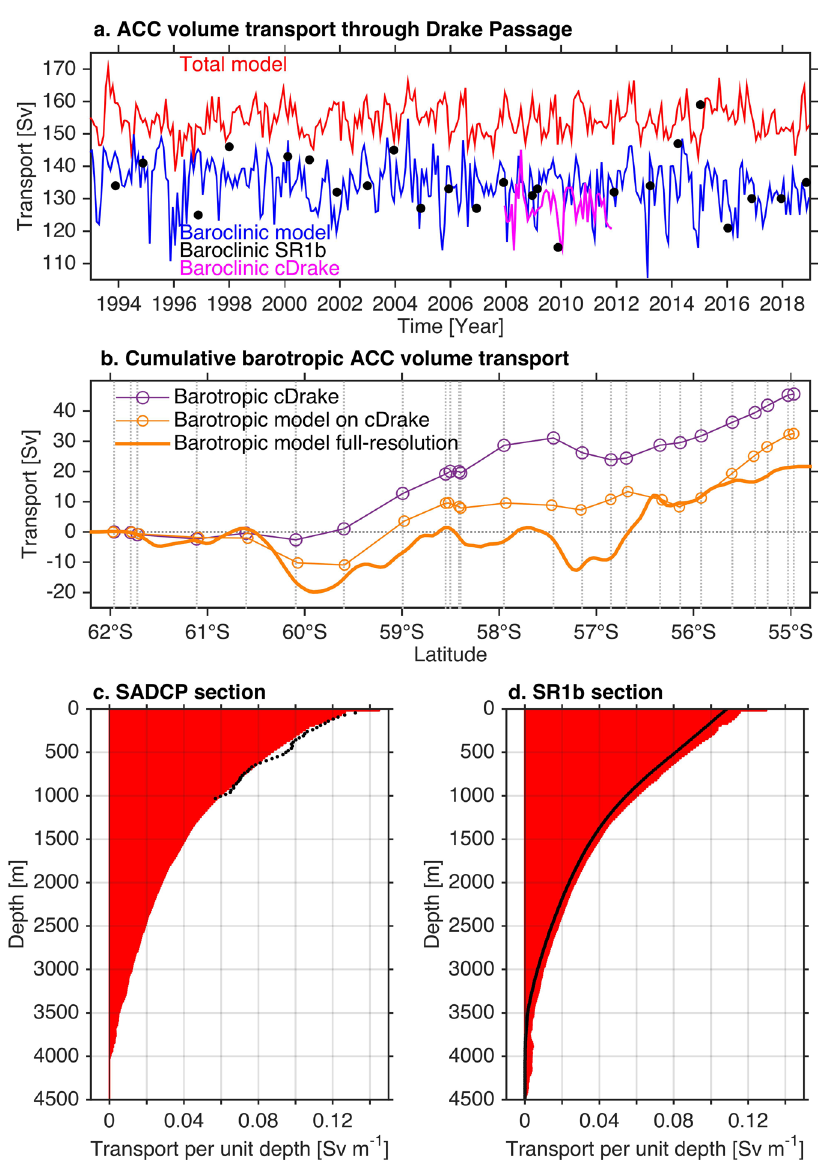
Fig. 5 Volume transport through Drake Passage. a Monthly values of total (red curve) and baroclinic (blue curve) transports across the repeat SR1b hydrographic section in Drake Passage computed from the HYbrid Coordinate Ocean Model (HYCOM) in comparison with baroclinic transport estimated from 24 SR1b hydrographic surveys 102 (black circles) over 1993 – 2018 and with monthly baroclinic transport (magenta curve) estimated from the continuous cDrake observations 191 from December 2007 to October 2011. The HYCOM transports (available between 1979 – 2020) are shown for the period 1993 – 2018 (coincident with the 24 SR1b observations). b Cumulative barotropic Antarctic Circumpolar Current (ACC) transports from south to north across Drake Passage 102 . The circled purple line is the cumulative barotropic transport based on cDrake observations 192 ; the circled and thick orange lines are the HYCOM-modeled cumulative barotropic transports calculated using velocities subsampled at the cDrake mooring locations and at the full model resolution, respectively. The dashed vertical lines and circles indicate the cDrake mooring locations. c , d Vertical pro fi le of transport per unit depth as a function of depth at the Drake Passage repeat SADCP section and repeat hydrographic SR1b section from HYCOM and observations 102 . The red horizontal bars are the HYCOM-modeled total transport. In c , the black circles are SADCP observations 198 . In d , the black circles are baroclinic transports based on the long-term SR1b hydrographic surveys. Positive transports correspond to eastward fl